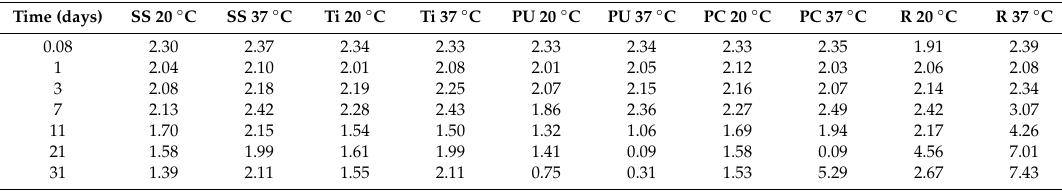
Table 5. B3 desamido insulin (iso-asparate (isoAsp) and asparate (Asp)) formed over time at 20 °C and 37 °C as a percentage of the total insulin peak area for method B.